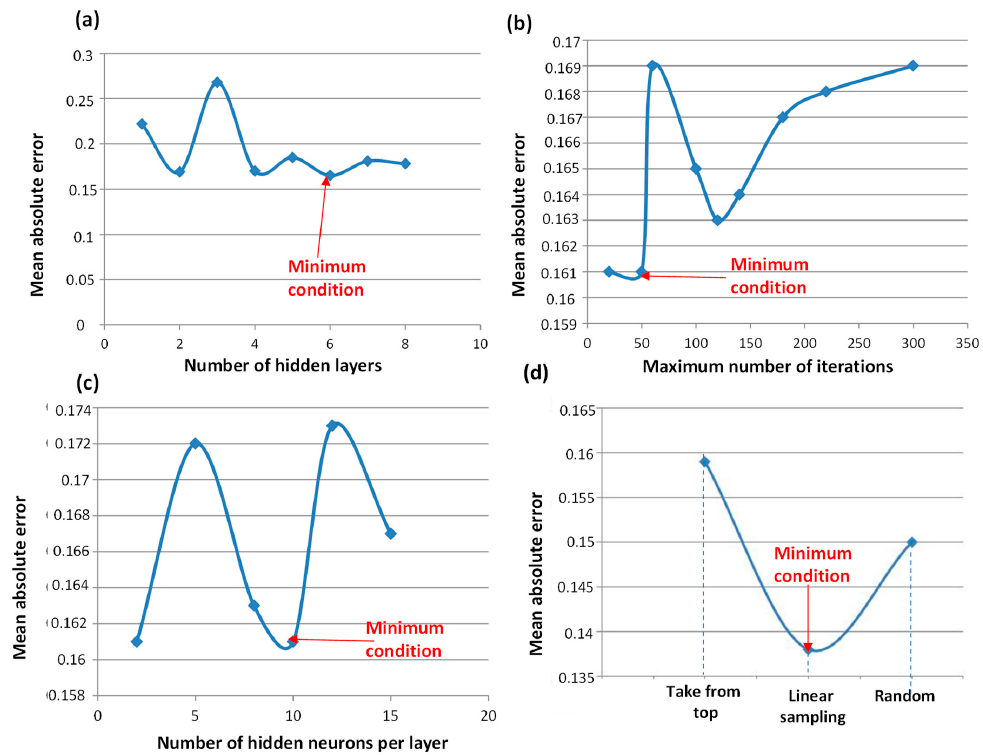
Figure 11. KNIME MLP prediction results of systolic values.